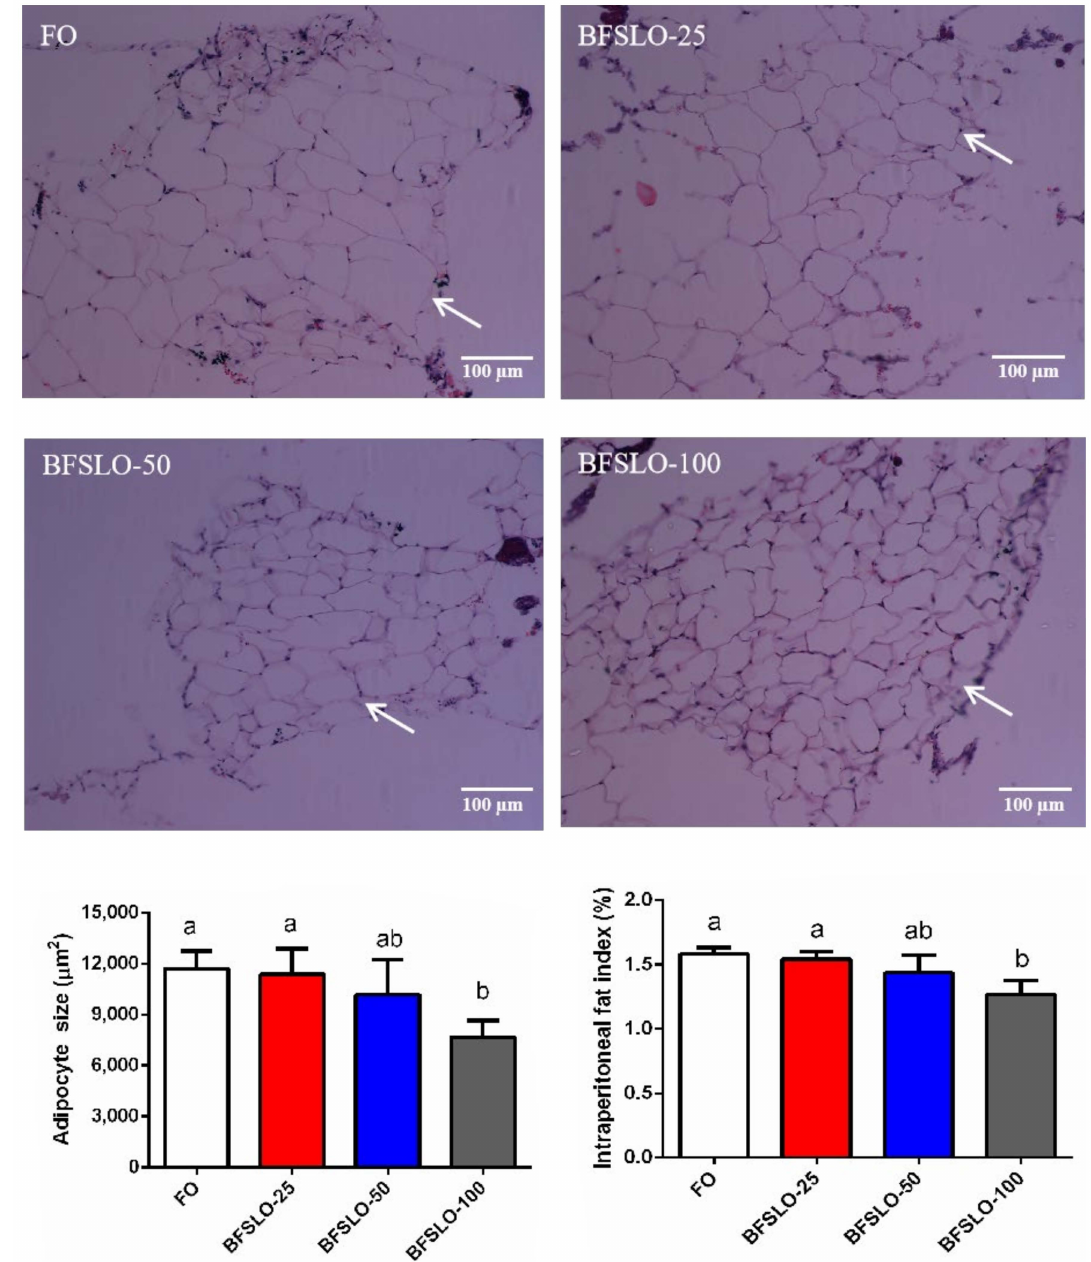
Figure 1. Morphology, the size of adipocyte and intraperitoneal fat index (IPFI) in O. macrolepis fed the four experimental diets with different gradient levels of BSFLO (25%, 50% and 100%) replacing FO (control) for eight weeks. Adipocyte size and IPFI value of fish in the BFSLO-100 group were significantly lower than those in the control group ( p < 0.05). Data are expressed as mean and SEM. Values with different superscripts (a, b, ab) in the same column are significantly different (one-way ANOVO) ( p < 0.05) The mean value of five non-overlapping images was computed for each